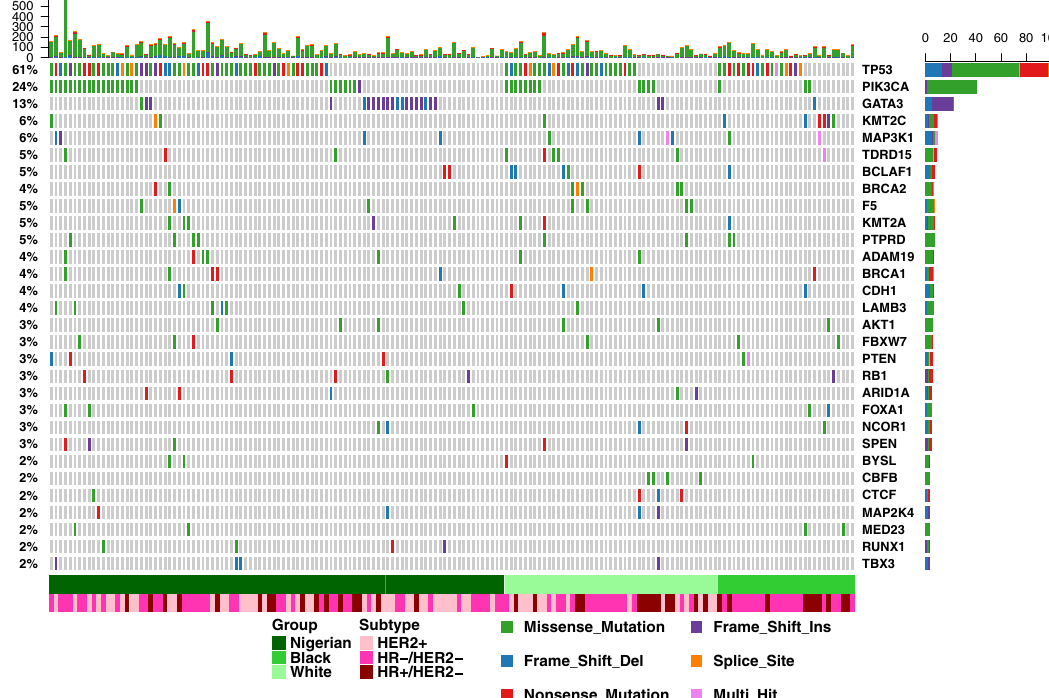
Fig. 1 Landscape of driver genes in breast cancer across different ethnic groups. Genes were identi fi ed using two different detection methods (cDriver and MutSigCV; n = 13). Breast cancer drivers not detected due to insuf fi cient statistical power ( n = 173 independent tumors) but frequent in this dataset ( ≥ 2%) were also added to the overall list of drivers of breast cancer ( n = 30) to visualize their distribution in the Nigerian, Black, and White groups. Multi- hit: more than one non-silent variant detected in a gene in one tumor.